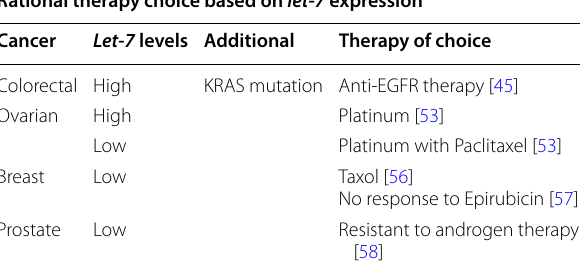
Table 3 Therapy of choice based on tumor let ‑ 7 levels in different types of cancer Rational therapy choice based on let - 7 expression